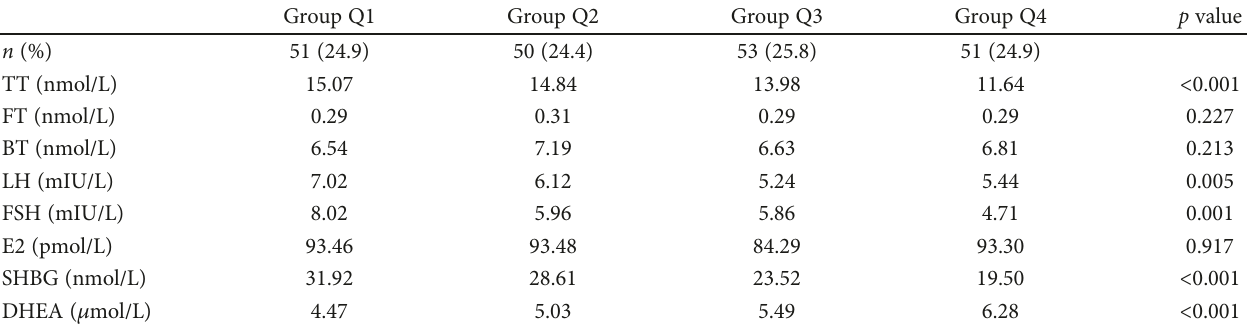
Table 2: Sex hormone levels in the study population disaggregated by quartiles of serum uric acid levels. Group